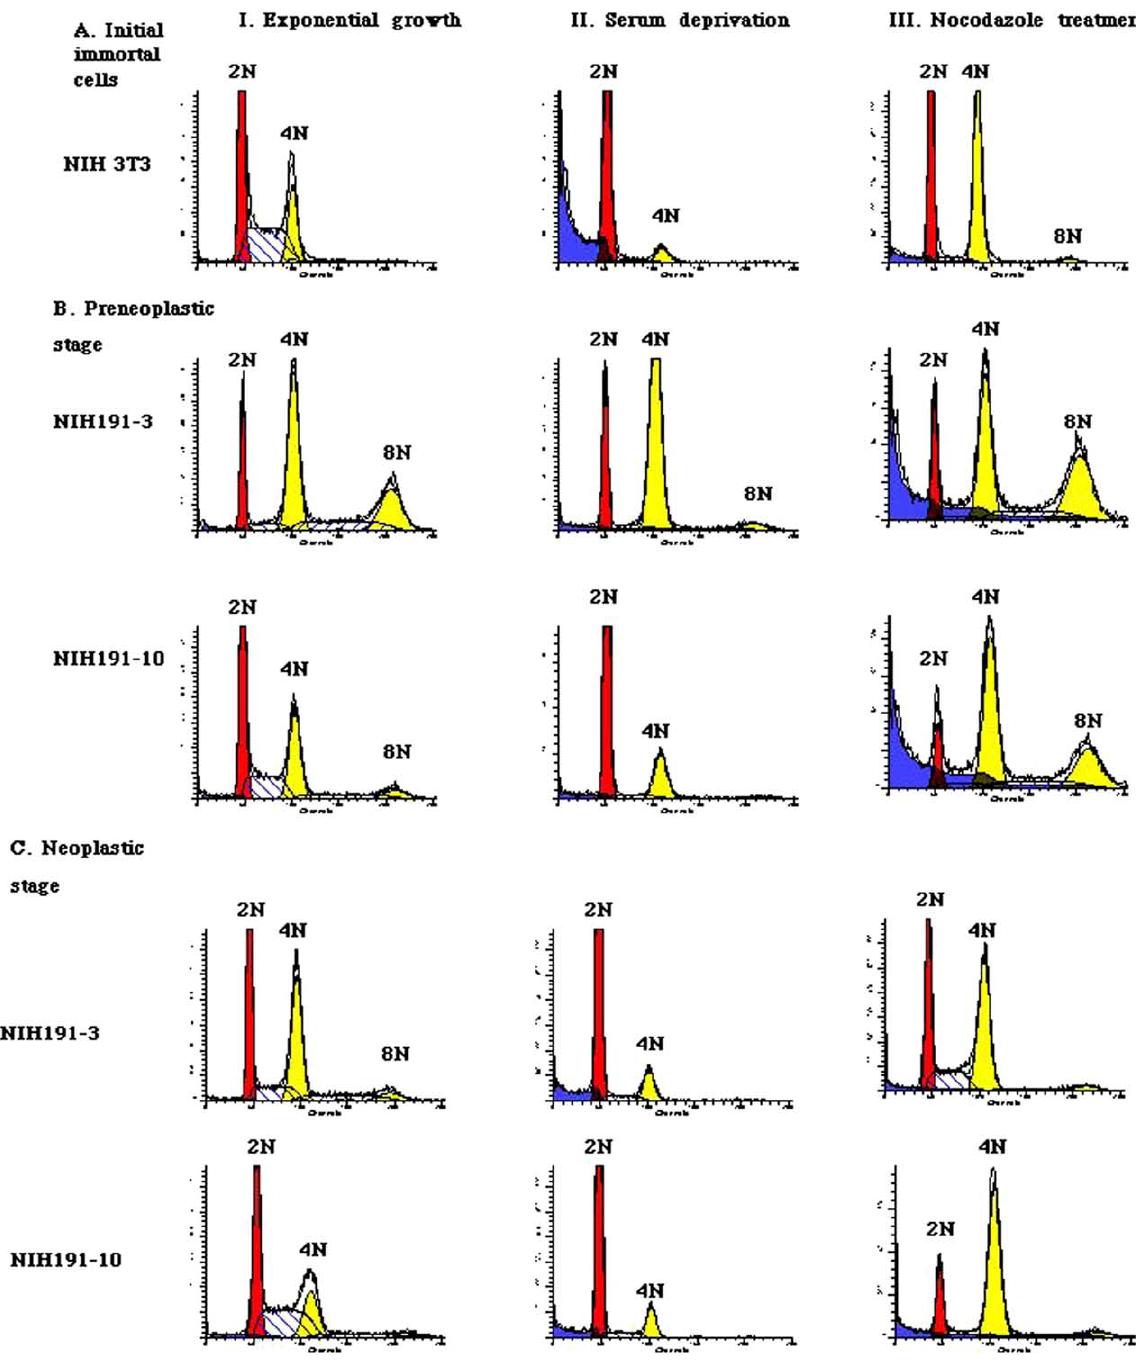
Fig. 4. Flow cytometry cell cycle analysis of NIH 3T3 (A), NIH191-3 and NIH191-10 cells at preneoplastic stage (B), and NIH191-3 and NIH191-10 cells at neoplastic stage (C). Panel I, cells growing exponentially; panel II, 6 days of serum starvation; panel III, 48 h of nocodazole treatment. X-axis, DNA content, Y-axis, number of cells. NIH 3T3 is an aneuploid cell line, but for convenience is called “diploid”. Diploid NIH 3T3 cells in G0/G1 are marked 2N (red colour), diploid G2/M and tetraploid G0/G1 cells are indicated as 4N, tetraploid NIH 3T3 cells in G2/M are indicated as 8N (yellow). DNA content between 2N and 4N corresponds to the diploid S-phase cells, and between 4N and 8N, to tetraploid S-phase